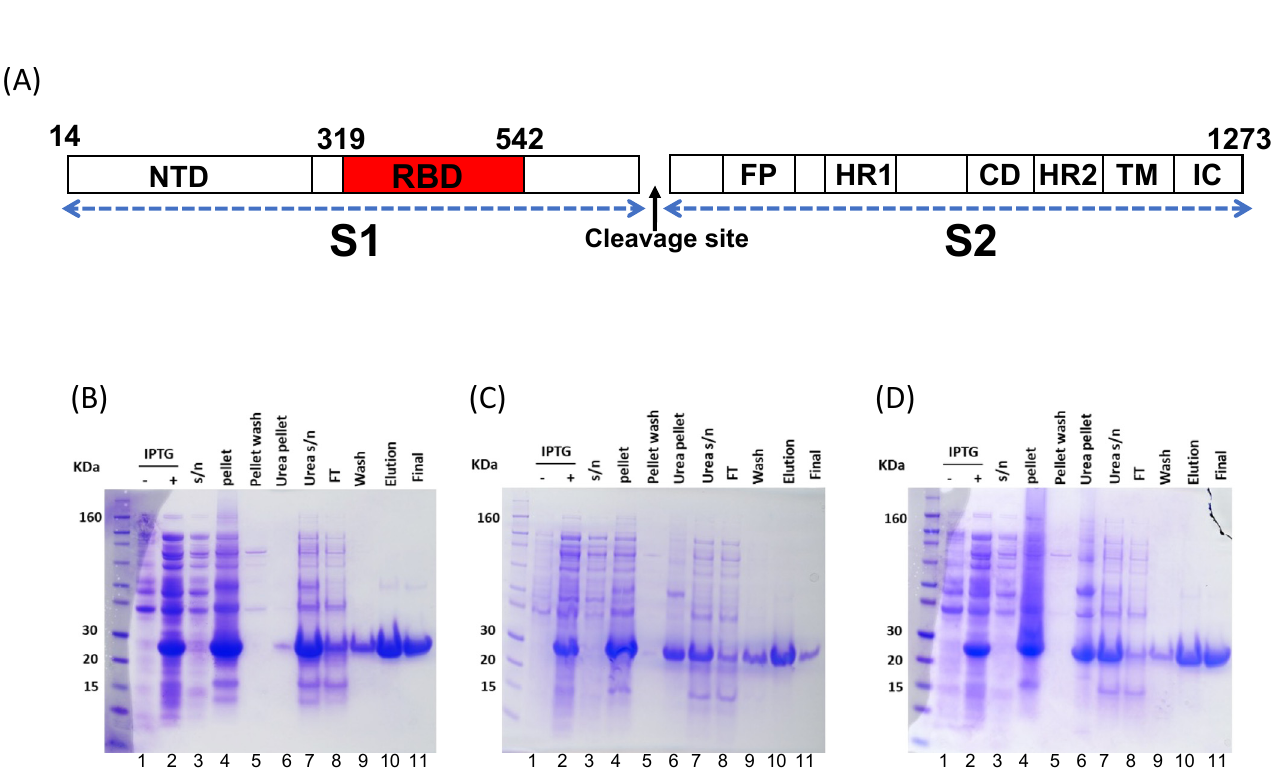
Figure 1. An overview of the domain organization of SARS-CoV-2 ′ s RBD and its purification from the E. coli expression system. ( A ) Domain architecture of the spike (S) protein of SARS-CoV-2 (not to scale). The subdomain 1 (S1) contains the N-terminal domain (NTD, a.a. 14 − 305) and the receptor binding domain (RBD, a.a. 319 − 542). The receptor binding motif (a.a. 438 − 506) is contained within the RBD. Subdomain 2 (S2) contains the fusion peptide (FP) and two heptad repeats (HR1, a.a. 908 − 985; HR2, a.a 1163 − 1214), which are separated by the connecting domain (CD). The S protein is anchored within the viral membrane by a transmembrane membrane helix (TM); the intracellular domain (IC) remains inside the virus. The S1 subunit is released post-cleavage during the fusion process. ( B ) Expression and purification of Wuhan-Hu1 variant, ( C ) Beta variant, and ( D ) Alpha variant RBDs from E. coli . Lanes 1 & 2, − /+ IPTG: whole-cell bacterial lysates; lane 3, s/n: supernatant resulting from microfluidization and centrifugation; lane 4, pellet: pellet resulting from cell lysis (inclusion body); lane 5, inclusion body wash; lane 6, pellet resulting from urea solubilisation of inclusion body; lane 7, urea solubilized inclusion body (input for Ni-NTA); lane 8, FT, flow-through from Ni-NTA; lane 9, wash Ni-NTA; lane 10, elution Ni-NTA; lane 11, final RBD product post-dial- ysis.